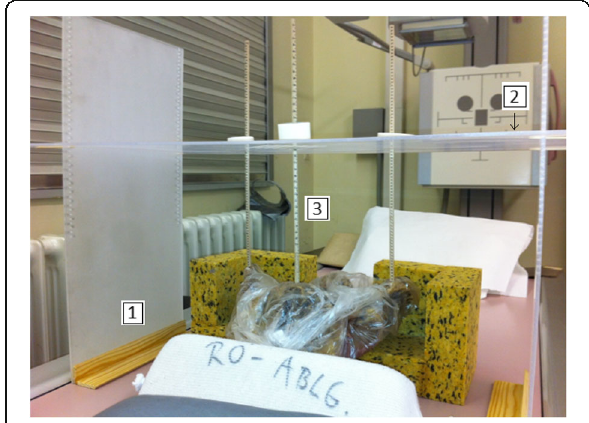
Fig. 1 Positioning device I: vertical acrylic glass panel attached to wooden base (1), height adjustable horizontal acrylic glass panel (2) with guide slots for the styli (3). The styli were placed in the same height on the superior anterior iliac spines and the pubic